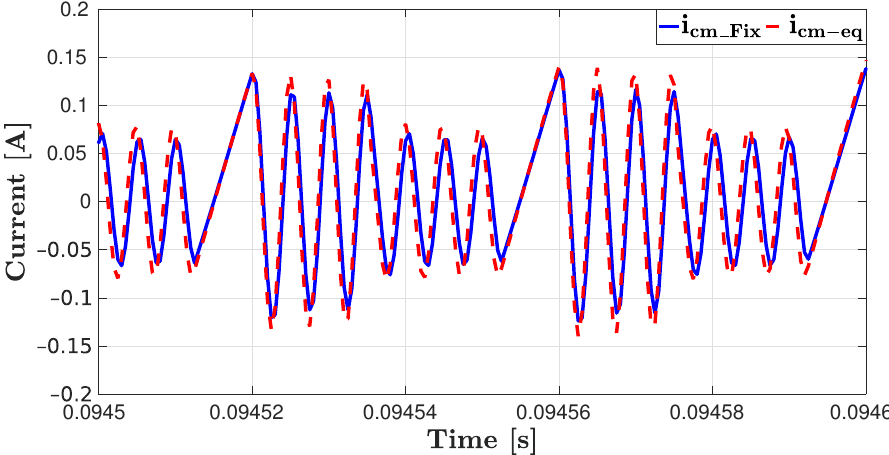
Figure 13. Comparison between i cm _ Fix (blue line) and i cm − eq (dashed red line) with fixed